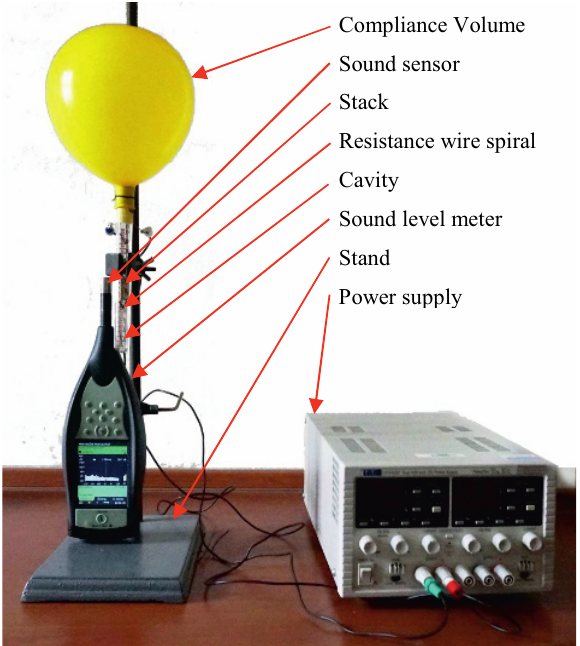
Figure 1. Scheme of thermoacoustic